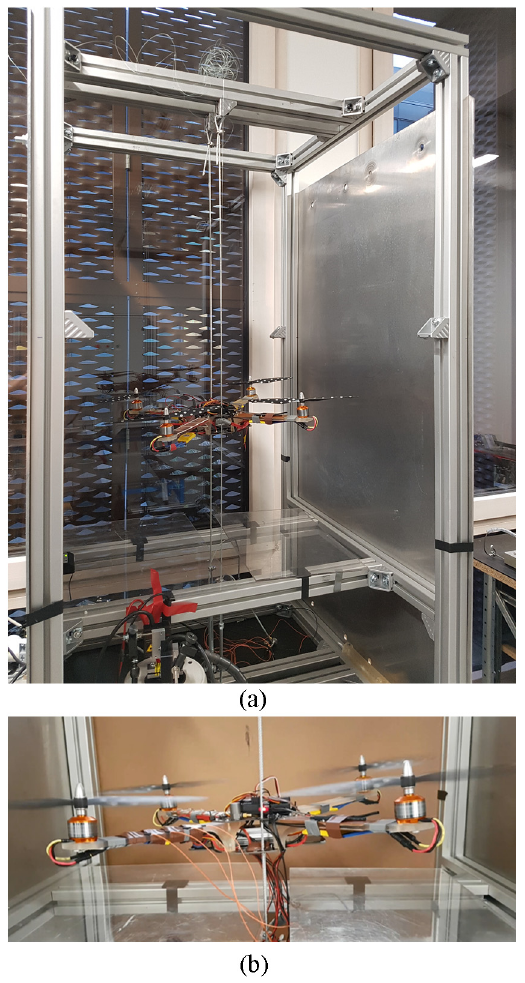
Fig. 8. (a) Cage used to test the different drones under real conditions and (b) revised drone in hovering fl